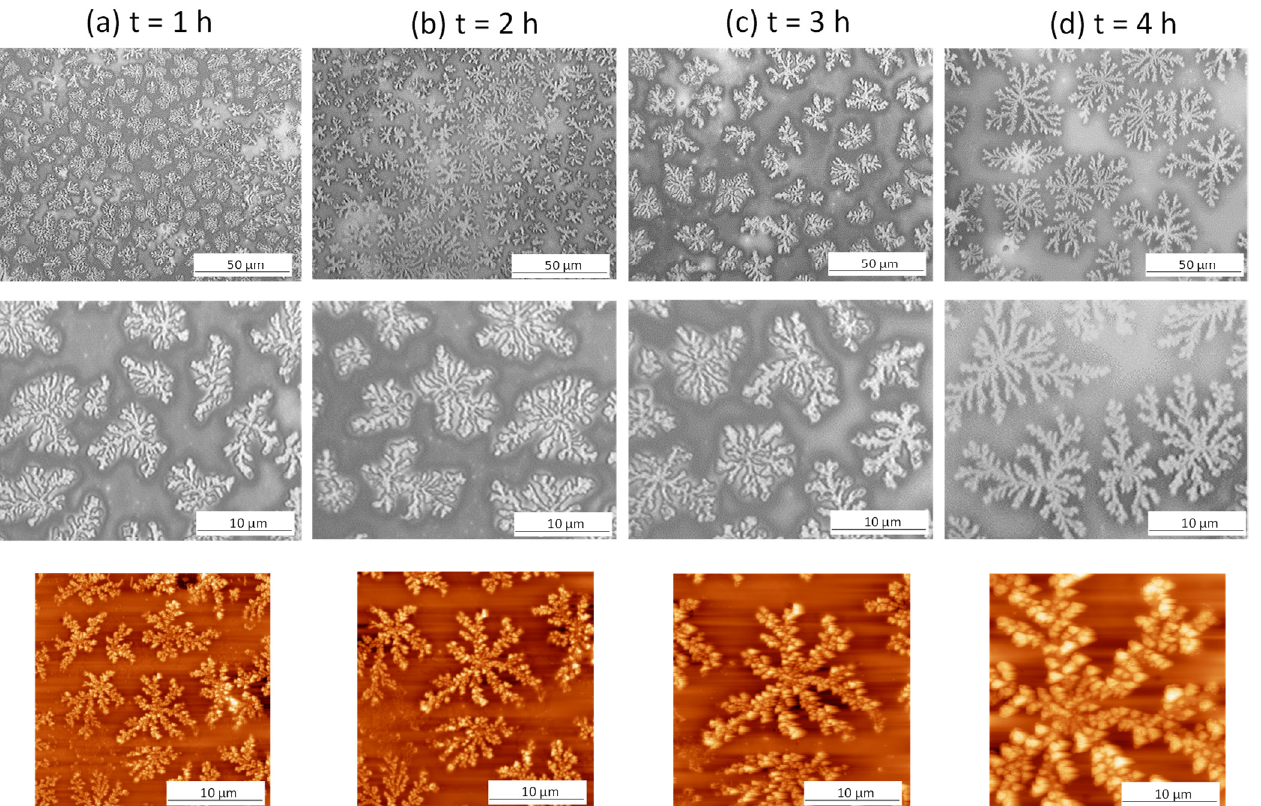
Figure 3. Effect of controlled hydrolysis in controlled moist air on morphological changes of plasma- polymerized thin nanocomposite films p(MA+CNC) with MA/CNC = 1/200 after different times of hydrolysis: ( a ) 1 h, ( b ) 2 h, ( c ) 3 h, ( d ) 4 h, according to optical microscopy ( top rows ) and AFM ( bottom row ).